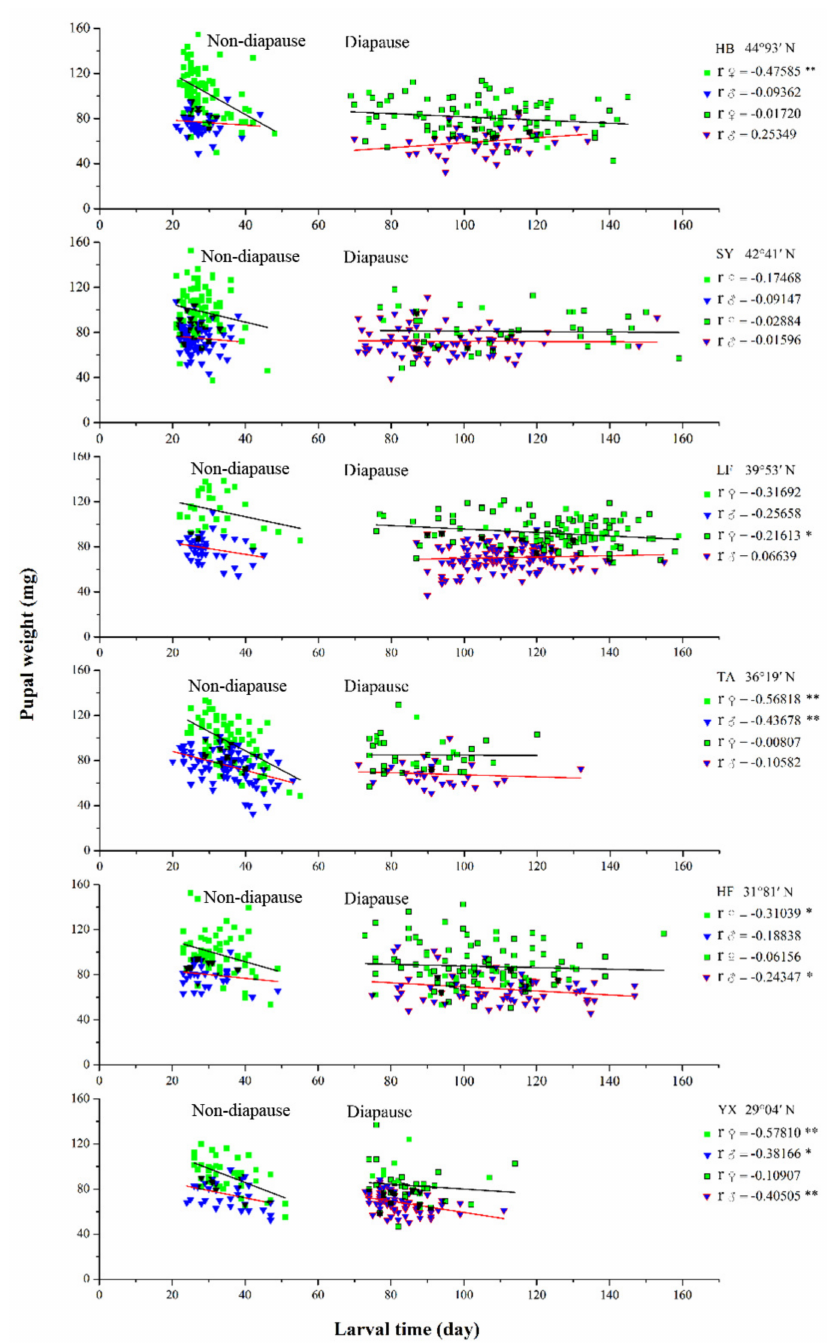
Figure 6. Relationships between larval developmental time and pupal weight for non-diapausing and diapausing individuals in different geographical populations of Ostrinia furnacalis . The asterisk indicates a significant correlation existed between larval developmental time and pupal weight (* p ≤ 0.05, ** p ≤